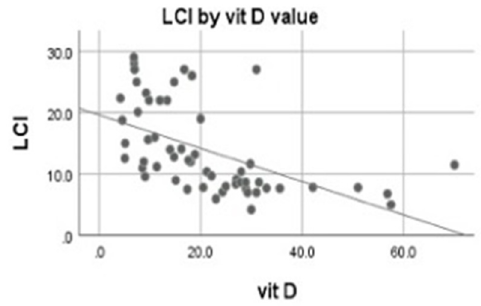
Figure 3. LCI variation by vitamin D